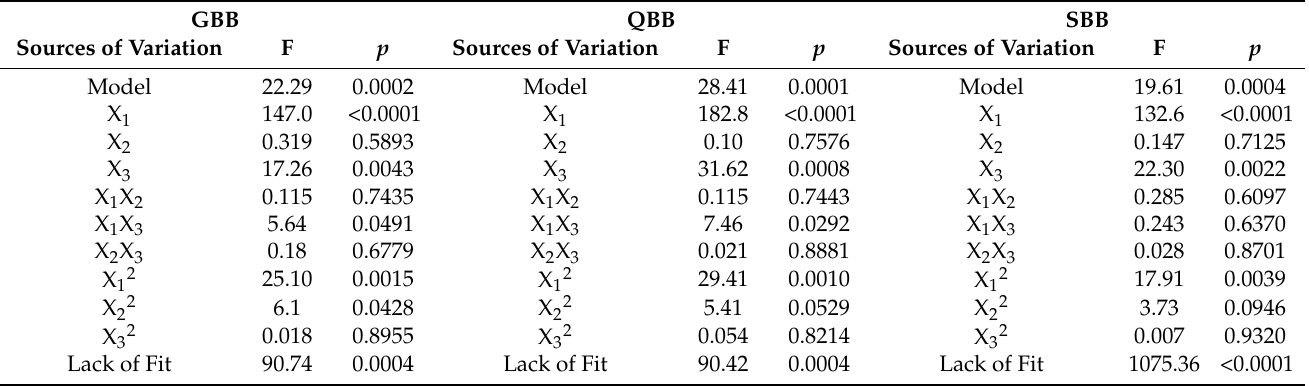
Table 6. Significance analysis of regression equation for cadmium ion adsorption by three biochar.